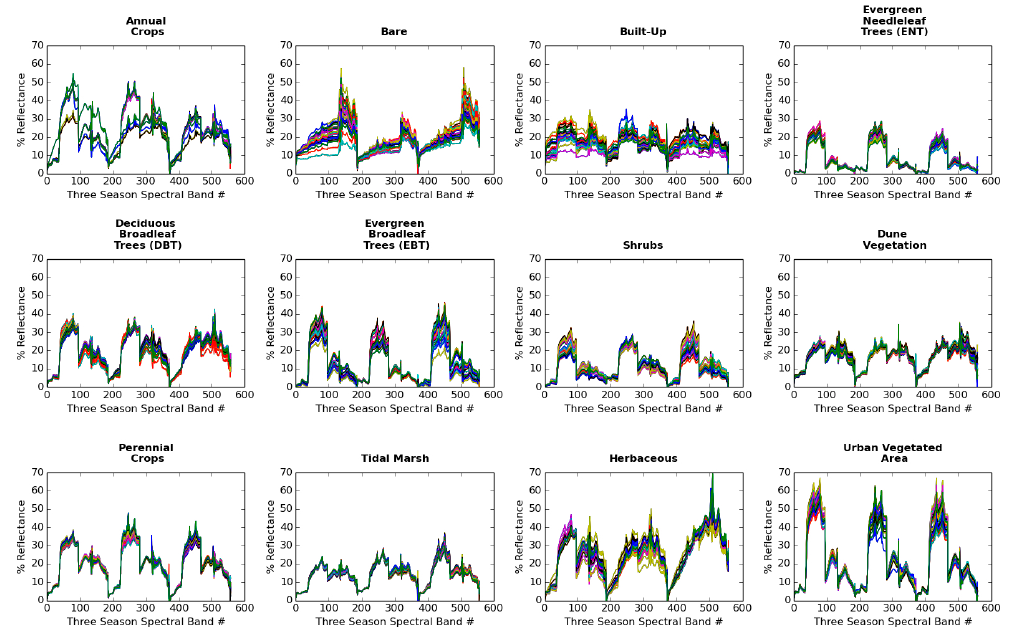
Figure 2. Twenty-five randomly selected three-season reflectance spectra from each of the twelve LCCS classes. Note that the x-axis is the band number (1–558) with seasons in spring- summer-fall sequence. Bad bands have been removed within each season (186 bands per season).